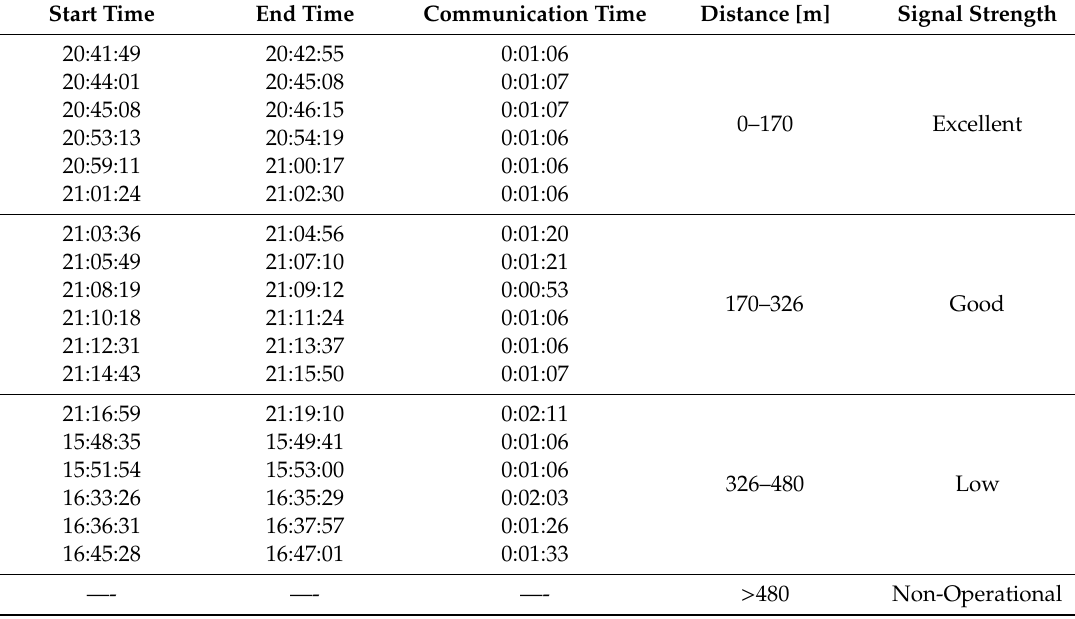
Table 9. Communication